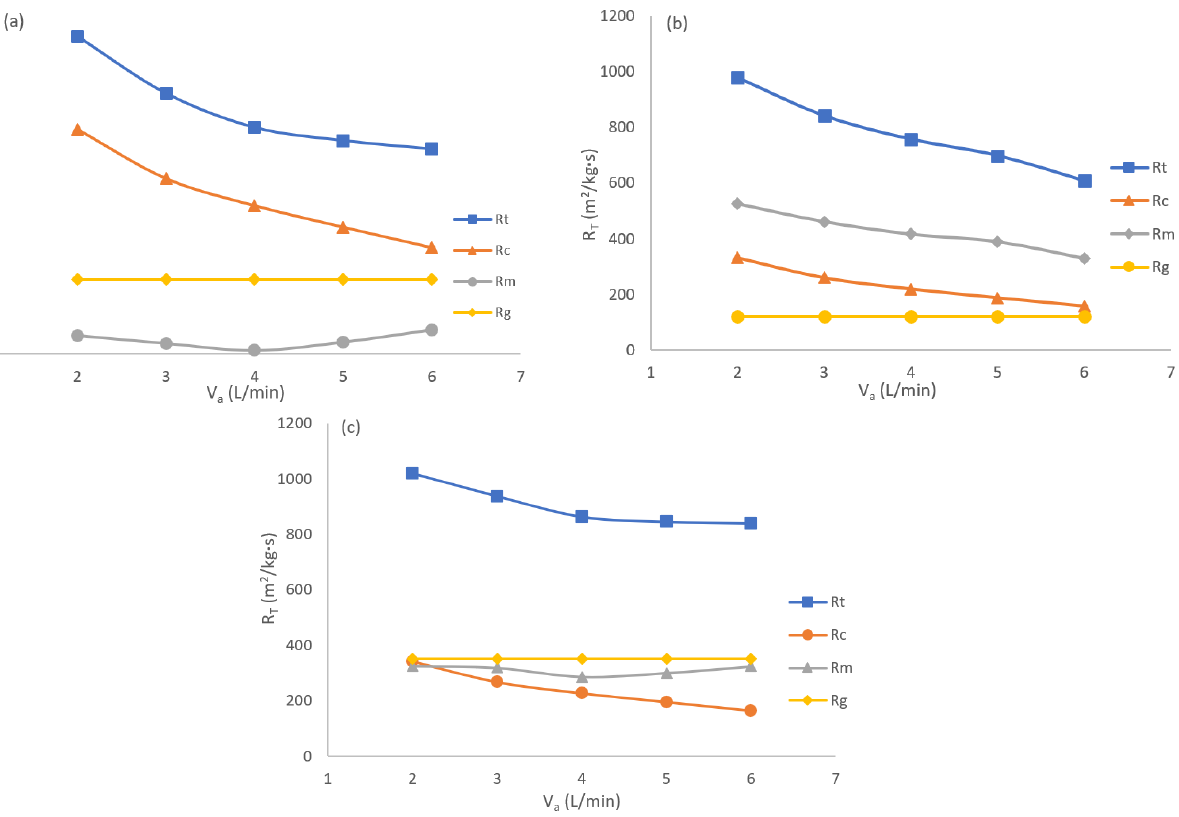
Figure 9. Mass transfer resistances for different airflows ( a ) CA, ( b ) PE/PUR, ( c ) PET/PUR.